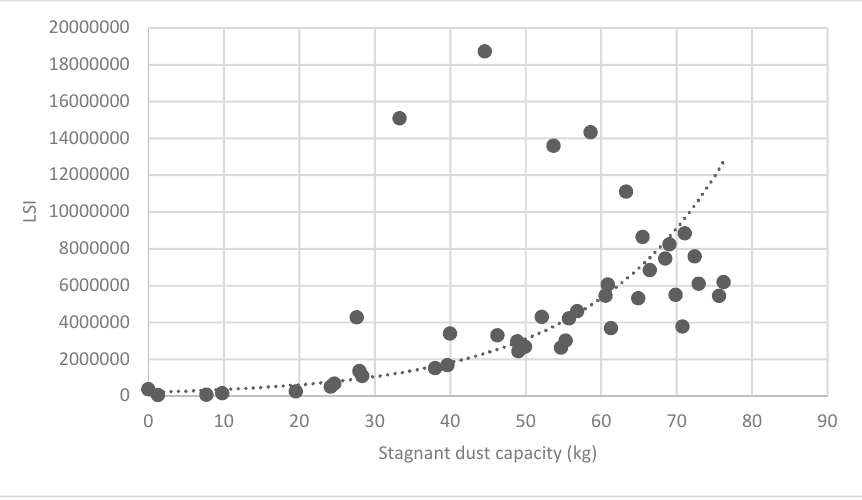
Figure 31. Association between brush LSI and stagnant dust capacity.